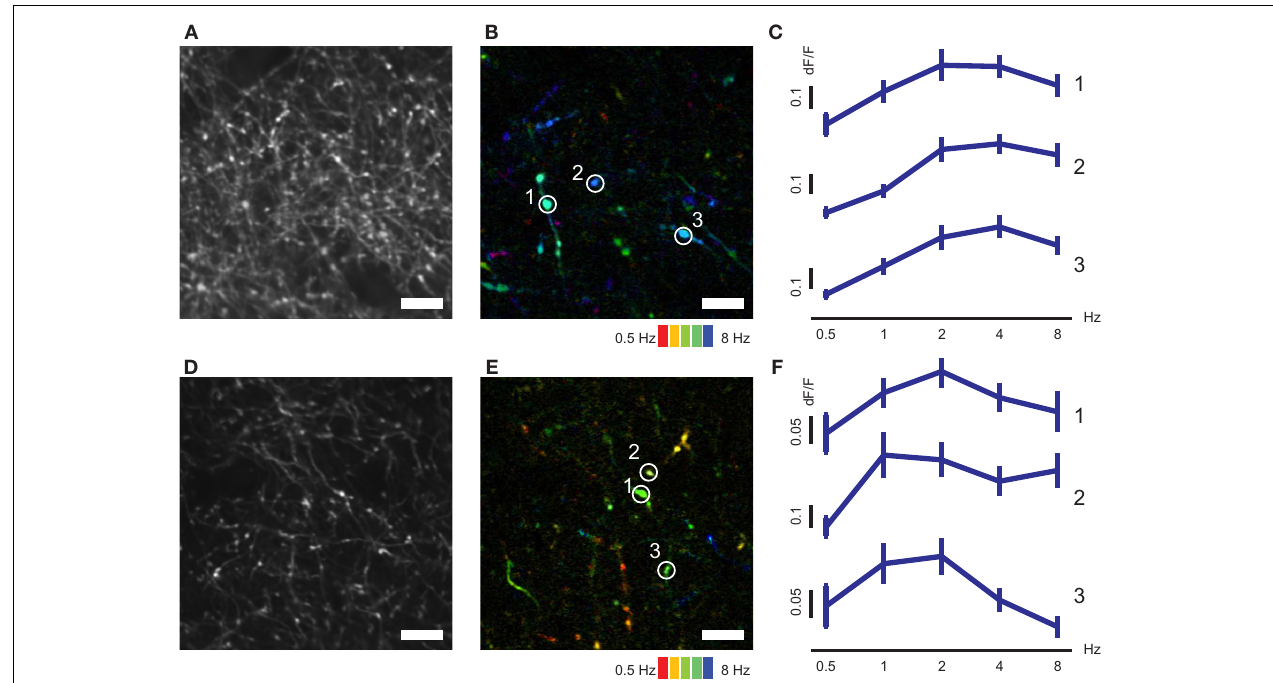
FIGURE 5 | TF–tuned responses of axonal boutons in AL and LM. (A) Representative FOV in LM. (B) Color-coded map of preferred TF of axonal boutons shown in (A) . (C) Representative TF tuning curves for three axonal boutons indicated by circles in (B) . (D) Representative